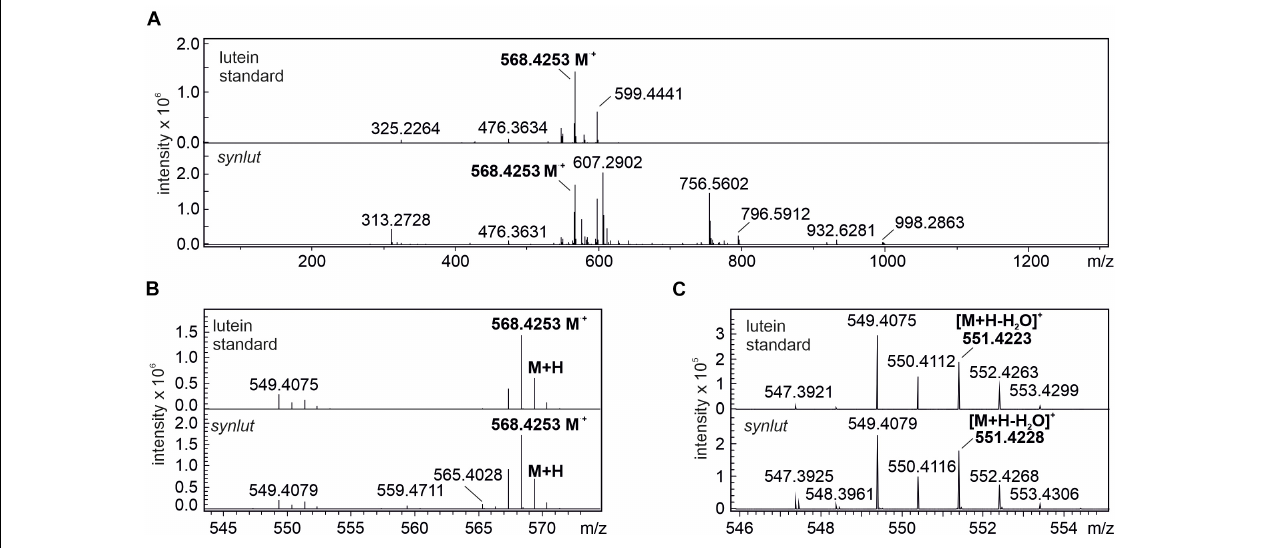
FIGURE 7 | MS spectra of lutein standard and peak 1 at retention time 4.2 min. (A) full spectrum scan (50–1300 m/z ) of the lutein standard and synlut at retention time of 4.2 min. (B,C) Close-up views of the mass range sections (B) 543–574 m/z and (C) 546–555 m/z . The radical ion formed by lutein (M ·+ , 568.4253 m/z ) and its water loss ion ([M + H-H 2 O] + , 551.4228 m/z ) are highlighted in bold